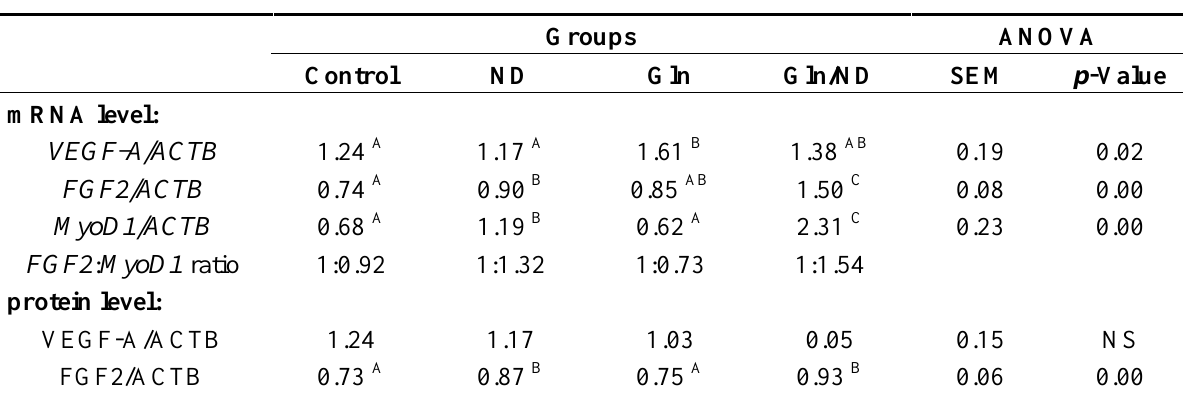
Table 4. Gene expression in the breast muscle tissue of chicken embryos in the control group and groups treated with nanoparticles of diamond (ND), L -glutamine (Gln), and bio-complex of Gln with ND (Gln/ND) at the mRNA and protein level. All results (mRNA and protein) were normalized to ACTB, n =